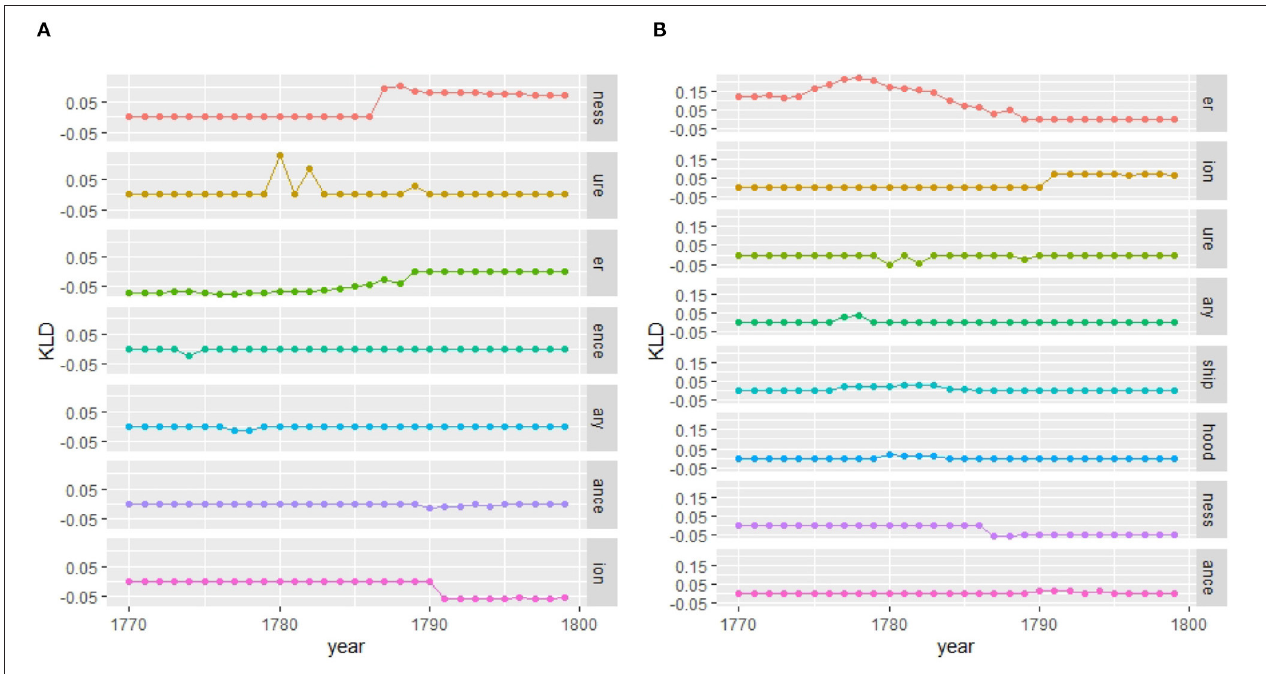
FIGURE 13 | Features contributing to period of change (from top to bottom showing highest to lowest contribution)—contemporary model women vs. men (suffixes). (A) Women. (B) Men.